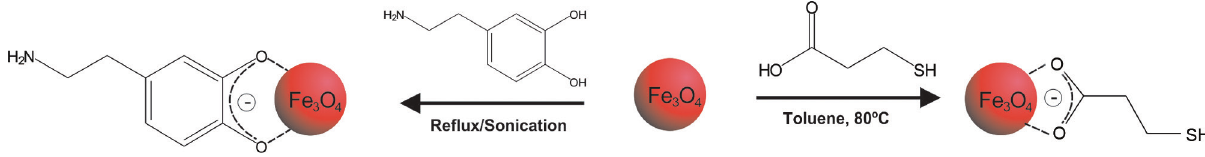
Figure 2 Amino- and thiol-functionalized magnetite NPs using MPA and dopamine